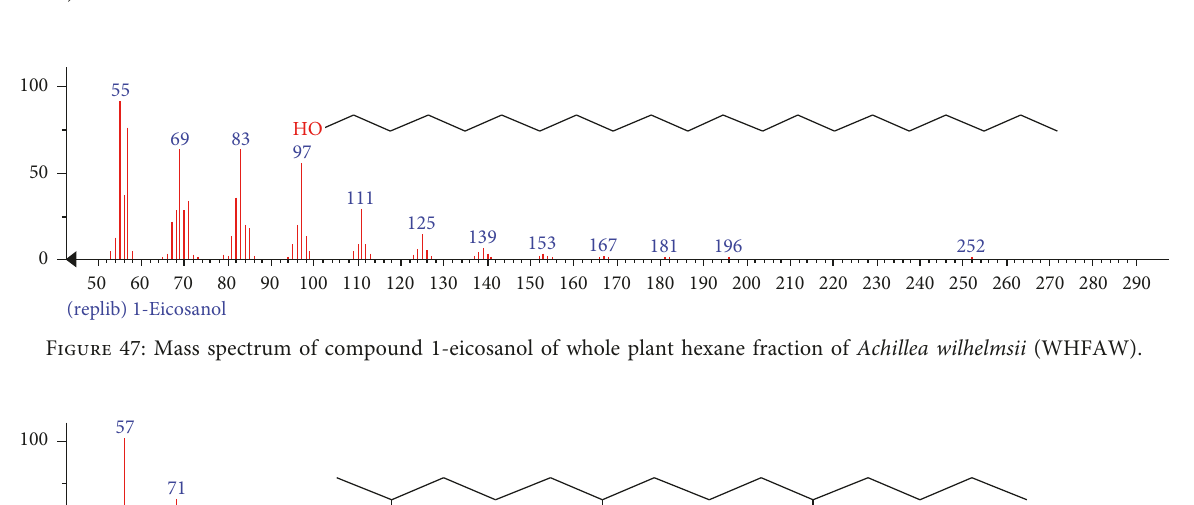
ester60 (mainlib) Hexadecanoic acid, 1,1-dimethylethyl Figure 46: Mass spectrum of compound hexadecanoic acid, 1,1-dimethylethyl ester of whole plant hexane fraction of Achillea wilhelmsii (WHFAW).